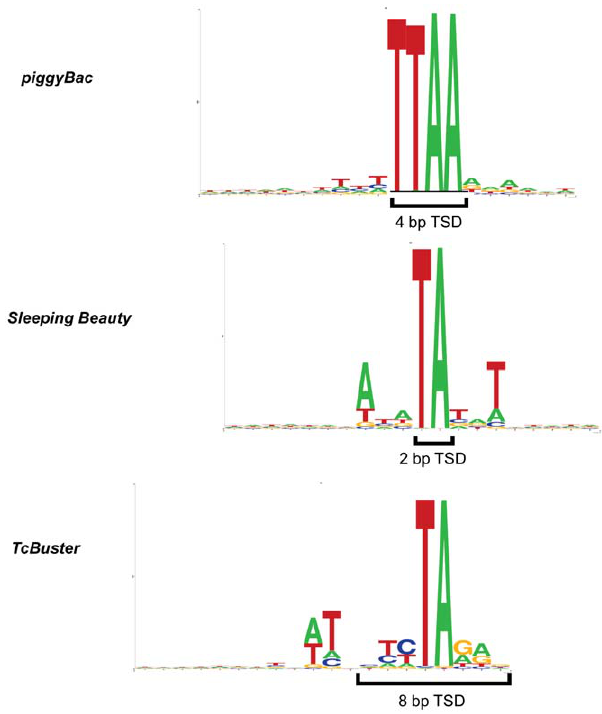
Figure 4. WebLogos generated from integration sites of piggyBac , TcBuster , and Sleeping Beauty transposons in HEK- 293 cells using the software at weblogo.berkeley.edu.